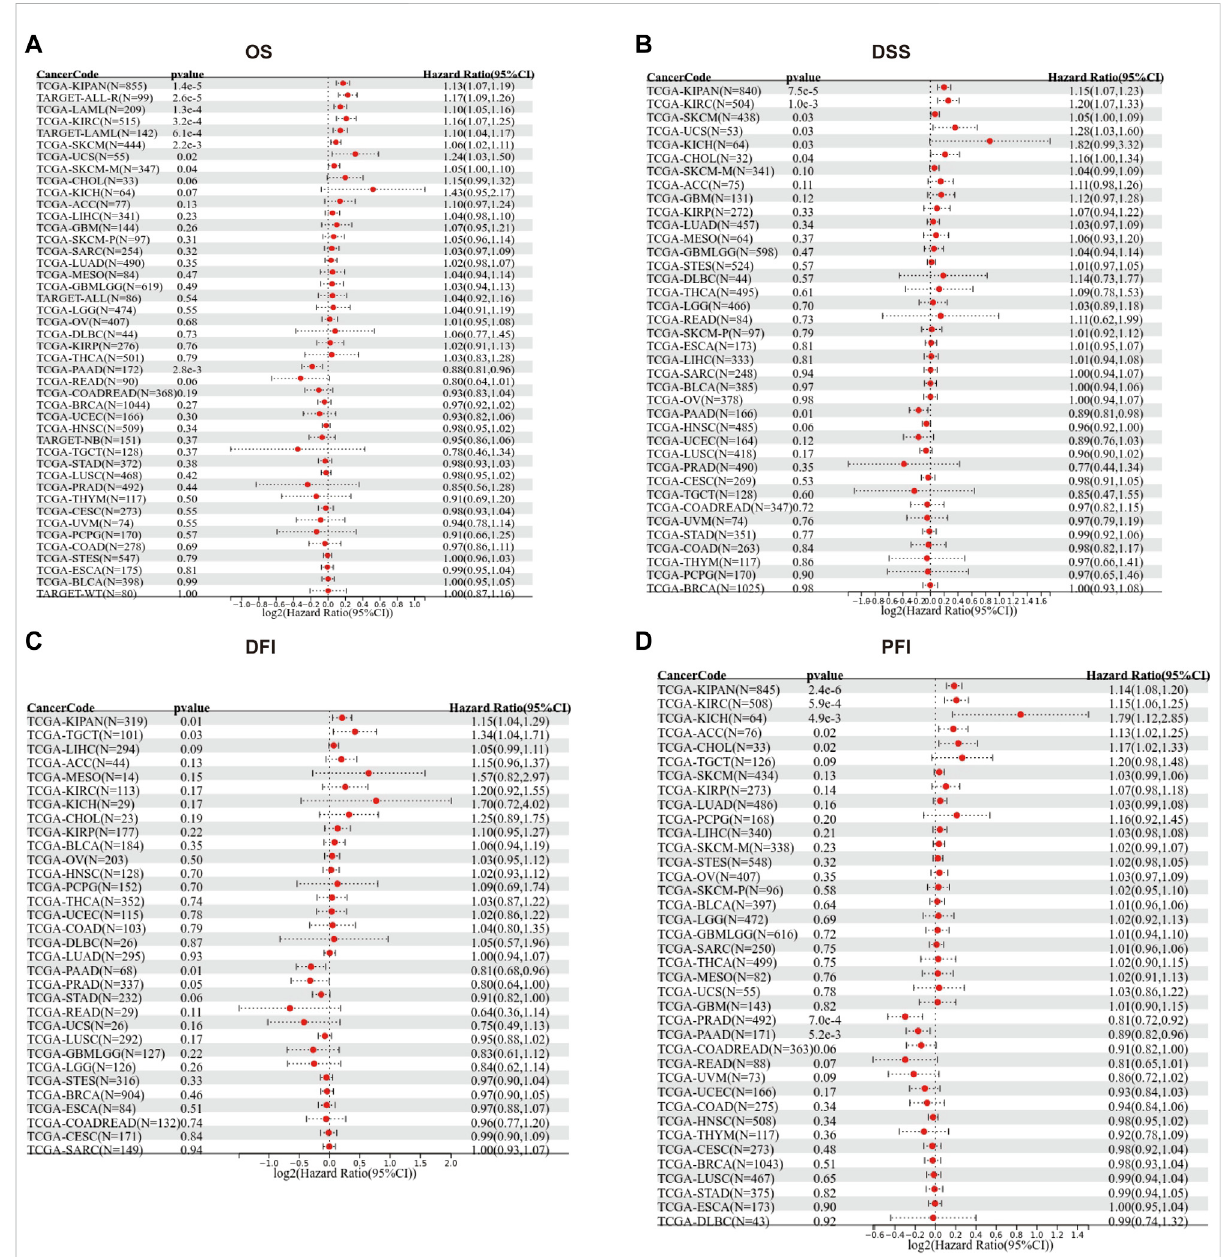
FIGURE 2 Forest maps showing the univariate Cox regression results of TGM3 for OS (A) , DSS (B) , DFI (C) and PFI (D) in pan-cancer